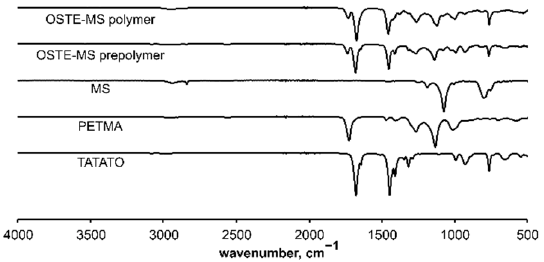
Figure 2. The FT-IR spectra of OSTE-MS polymer after heating 15 min, OSTE-MS prepolymer and monomers (MS, PETMA, TATATO).